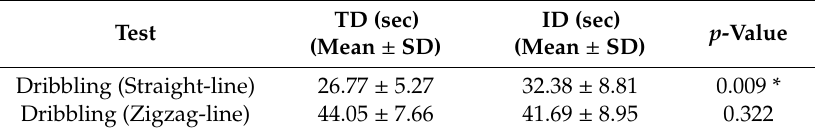
Figure 16. Results of the trunk tilt angle A trunk . The participants with ID displayed larger tilt angles in the straight-line test but lower angles in the zigzag line test. Table 12. ANOVA results of the trunk tilt angle in the two